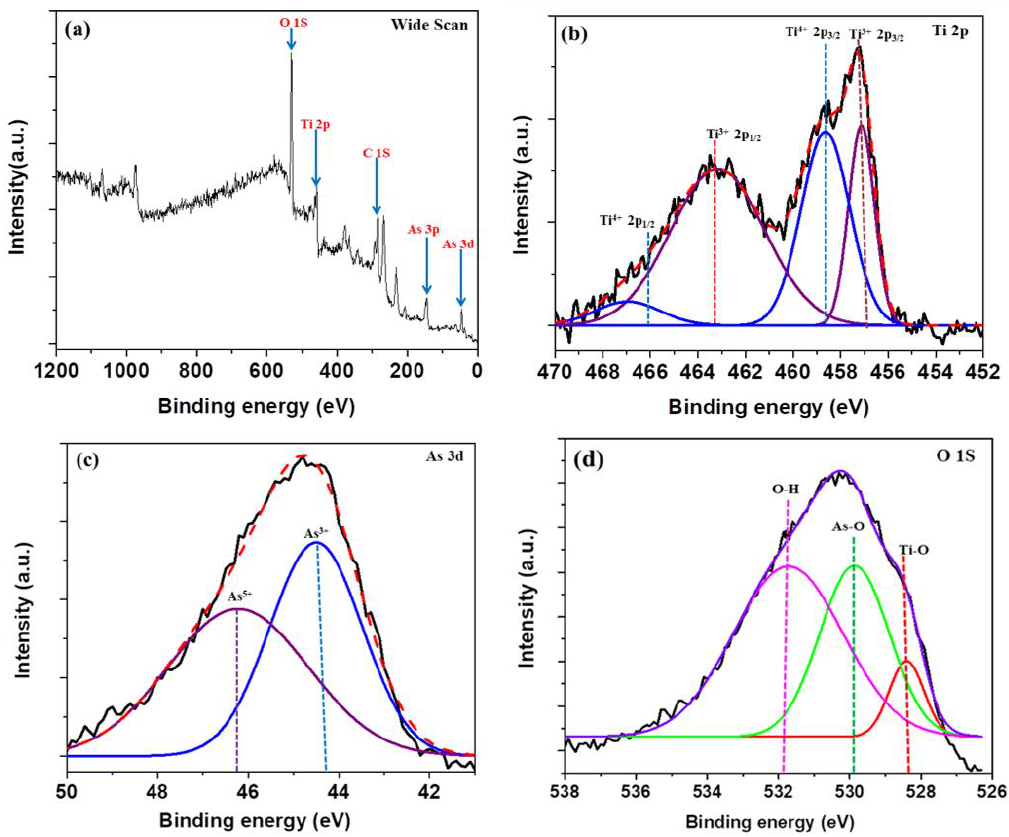
Figure 6. XPS spectra of PP@TiO 2 after As(III) adsorption: ( a ) Wide scan; ( b ) Ti 2p; ( c ) As 3d; ( d ) O 1s.